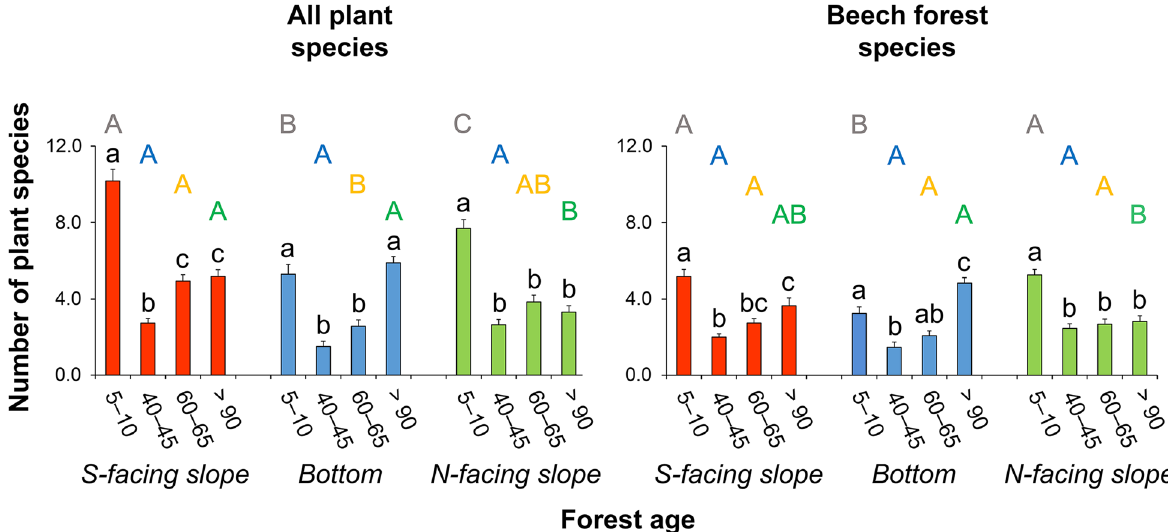
Fig. 6 Number of vascular plant species (all plant species and beech forest species) in the plots of topographic positions in dolines (south-facing slope, bottom, and north-facing slope) covered with different forest age classes (class 1: 5–10-year-old forest stands with mature forest patches, class 2: 40–45-year-old forests, class 3: 60–65-year-old forests, and class 4: more than 90-year-old forests) (mean on the GLMMs with Bonferroni post hoc tests) are indicated by different lowercase (a–c: between the same topographic positions of the different forest age classes, p < 0.05) and upper case (A–C in different colours: between the different topographic positions within a forest age class, p < 0.05) letters,